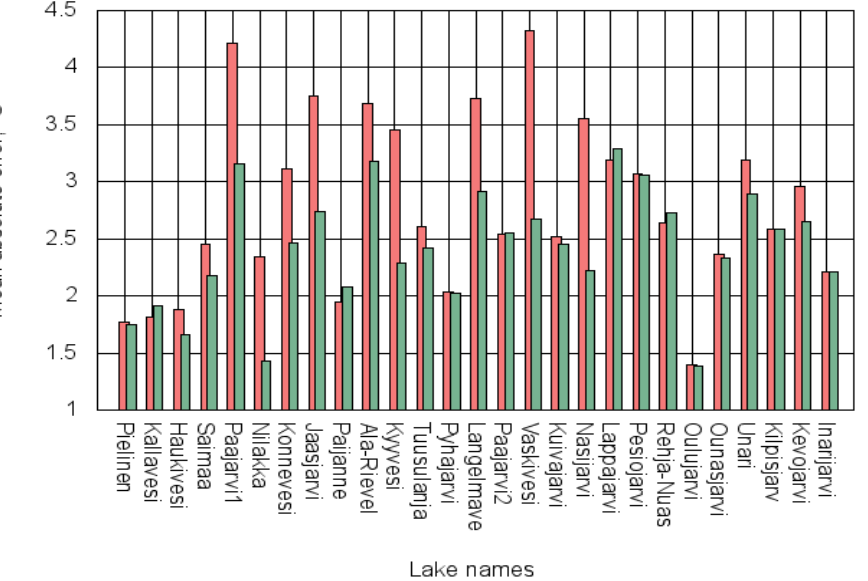
Figure 22. Lake temperature mean absolute error for 27 in-situ Finnish lakes over the 2010–2014 period. Results for the current operational system are in red and results with the updated lake depths are in